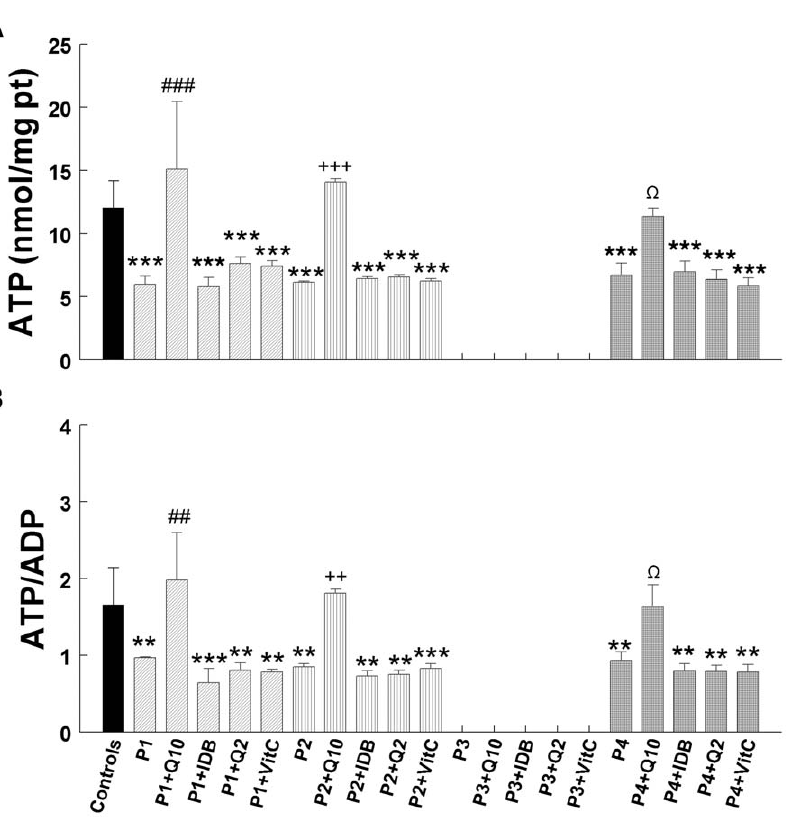
Figure 4. Bioenergetic status of cells after 1 week of treatment. Cultured skin fibroblasts from controls and CoQ 10 deficient patients were treated with 5 m M CoQ 10 , idebenone, CoQ 2 , or vitamin C. After 1 week, fibroblasts were collected and cellular ATP and ADP were determined by UV- HPLC. Data are represented as nmol of ATP/mg prot ( A ) and ATP/ADP ratio ( B ). Results are expressed as mean 6 SD of three experiments. P1= COQ9 mutant; P2= COQ2 mutant; P3= COQ2 mutant; P4= PDSS2 mutant. *** P , 0.001 and ** P , 0.01 compared with untreated control; ## P , 0.01 and ### P , 0.001 compared with untreated P1; ++ P , 0.01 and +++ P , 0.001 compared with untreated P2; V P , 0.05 and V V P , 0.01 compared with untreated